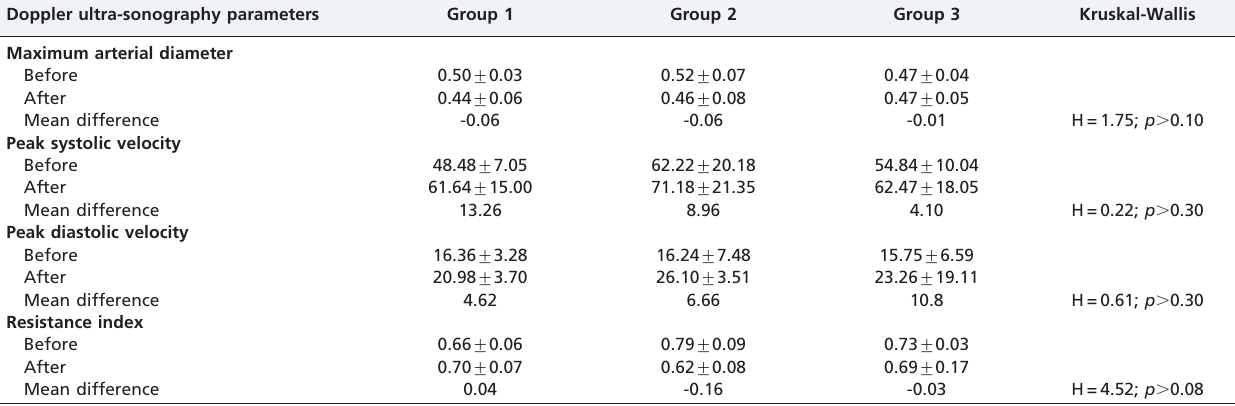
Table 2 - Doppler ultrasonography parameters (means ¡ standard deviation) before the lesion was created and after the placement of the covered stent and control arteriography in control and experimental groups.